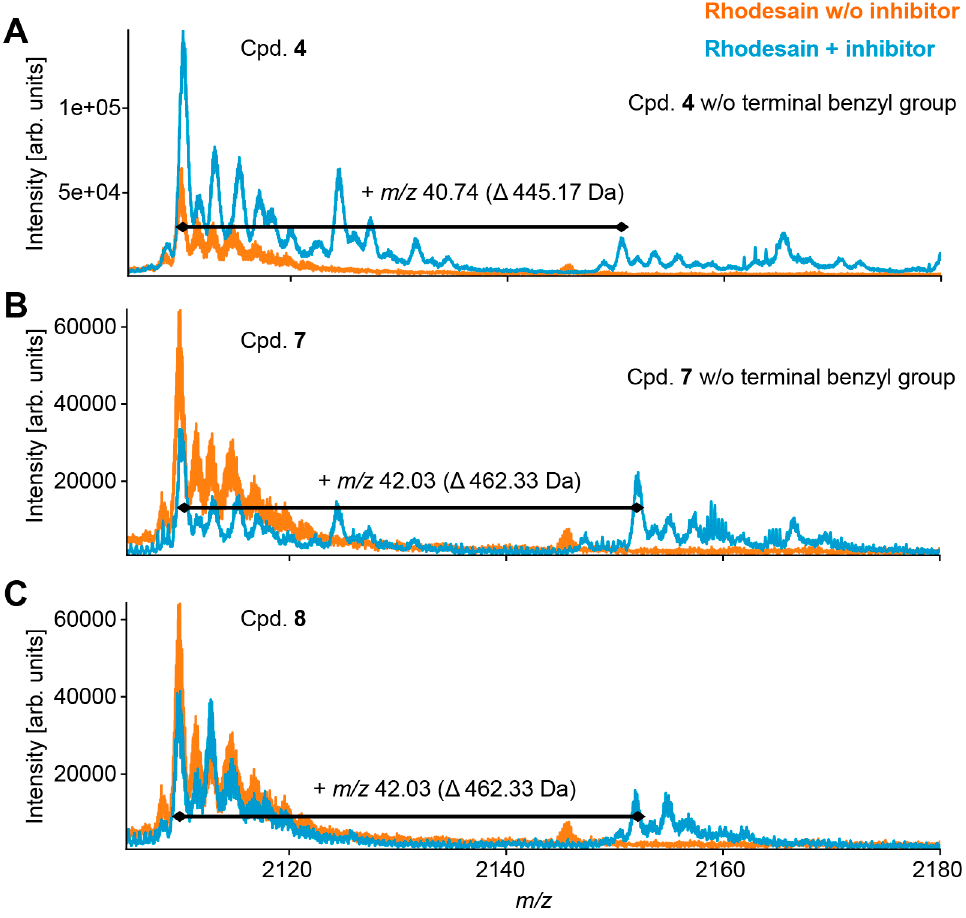
Figure 4. ESI-MS mass spectra of rhodesain ([M + 11 H] 11+ at m/z 2109.9 +/– 20 ppm) in the absence (orange) or presence (blue) of compounds 4 ( A ), 7 ( B ) and 8 ( C ).